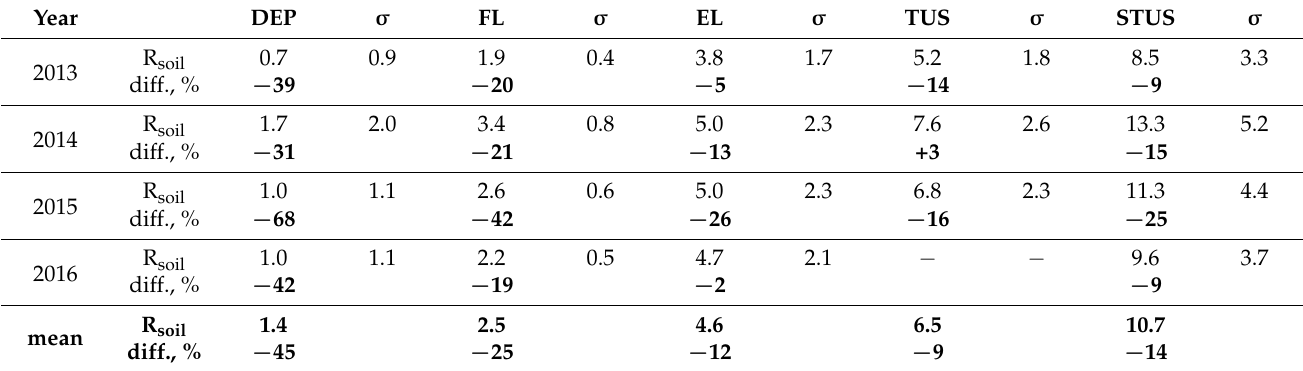
Table 5. The total R soil for the season calculated without considering extra dry periods (tC ha − 1 season − 1 ). The “diff” row shows its difference (in %) from the seasonal R soil calculated taking into account the periods of decreases in GWL.